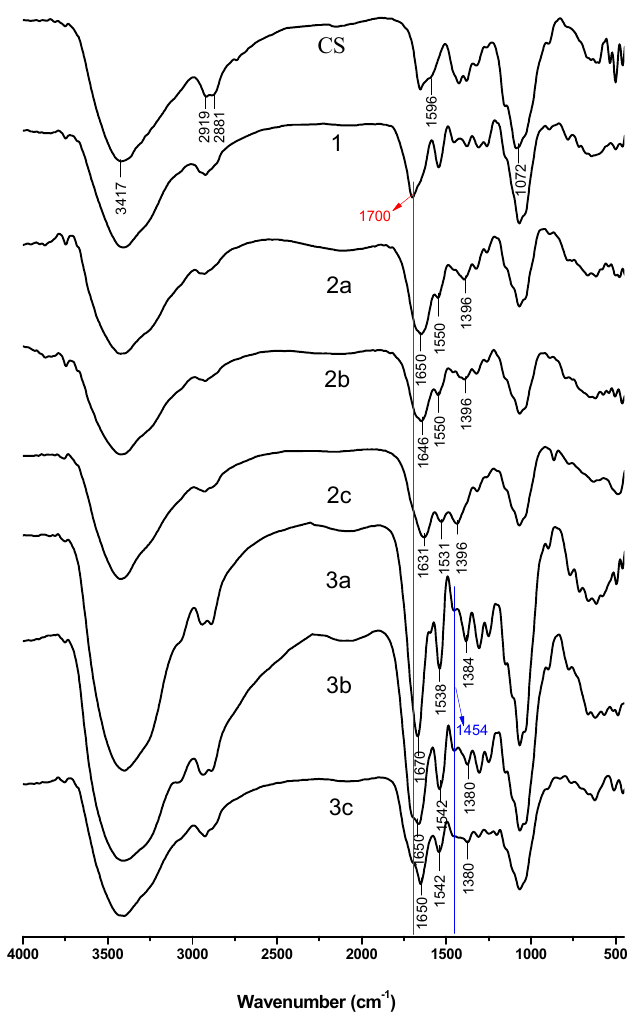
Figure 1. FT-IR spectra of chitosan and chitosan derivatives.